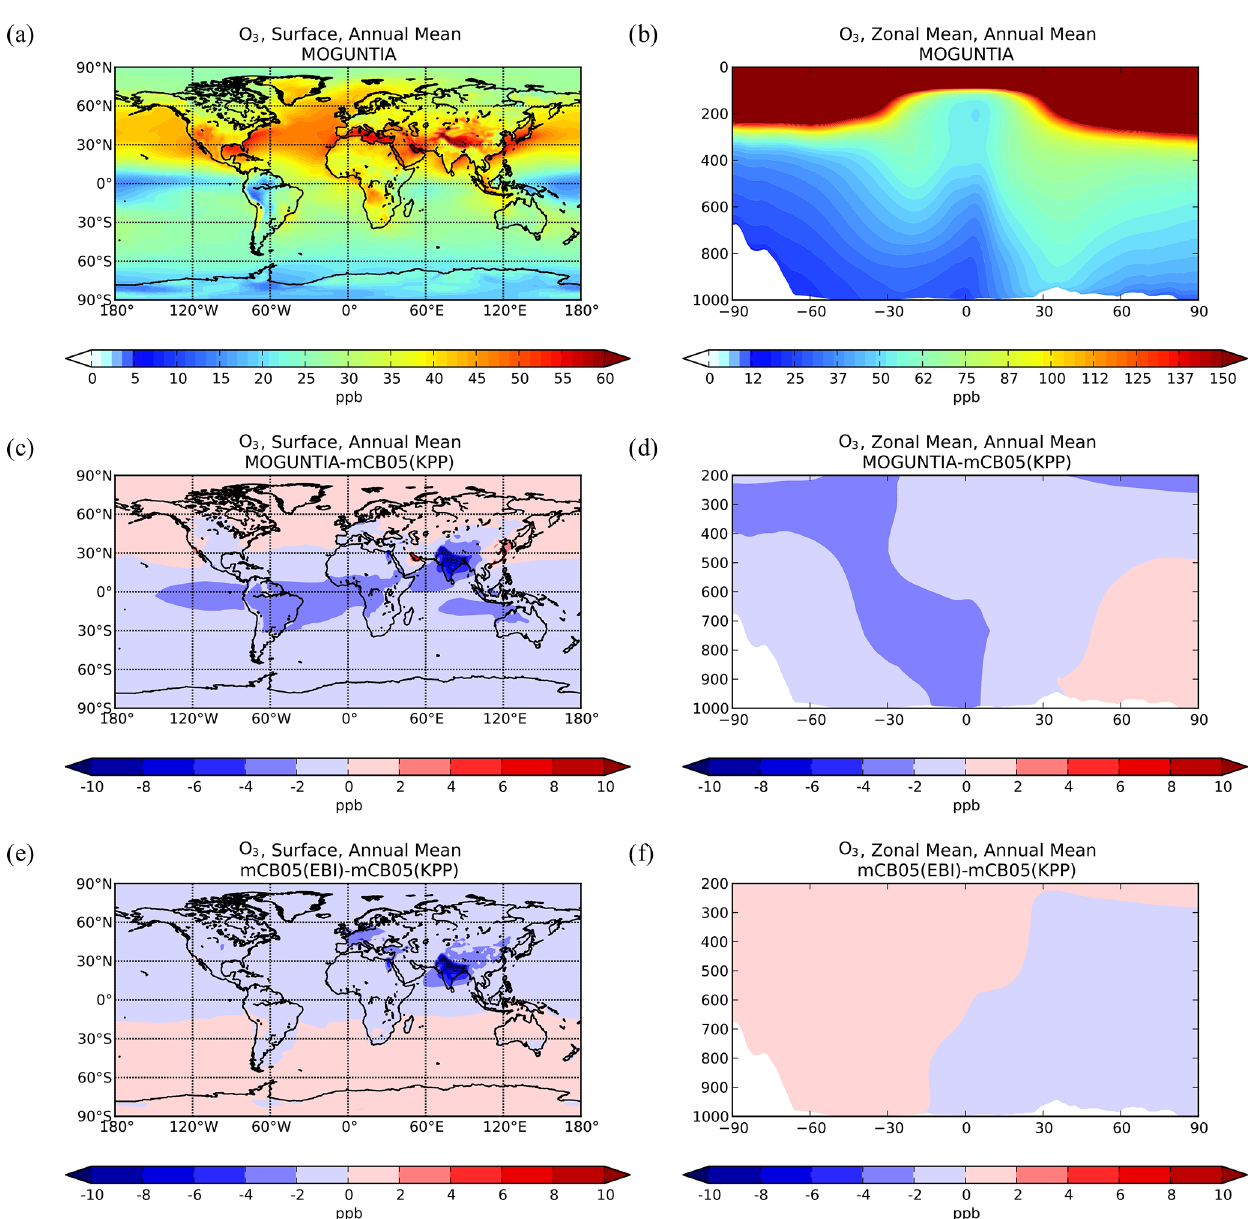
Figure 1. Simulated annual mean surface (a, c, e) and zonal mean (b, d, f) O 3 mixing ratios (ppb) for the MOGUNTIA chemistry scheme for the year 2006 (a, b) and the respective differences compared to mCB05(KPP) (c, d) ; the surface and zonal mean absolute differences between mCB05(KPP) and mCB05(EBI) are also presented (e, f)